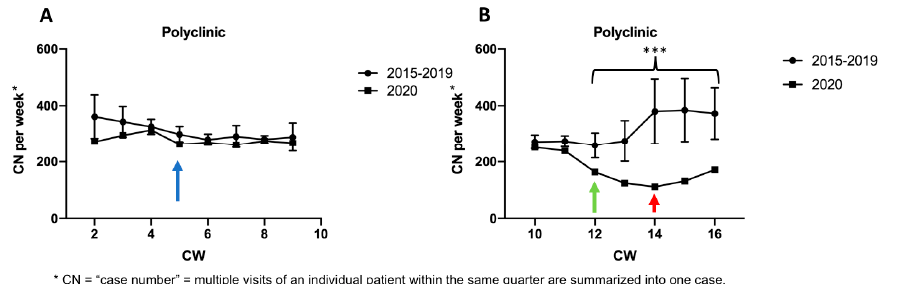
Figure 1. CN per week of the polyclinic. ( A ) Average CN per week between CW 2 and CW 9 from 2015 to 2019 compared to 2020. ( B ) Average CN per week between CW 10 and CW 16 from 2015 to 2019 compared to 2020. First case of COVID-19 reported in Bavaria in CW 5 (blue arrow), declaration of state of emergency in Bavaria in CW 12 (green arrow), beginning of the second accounting quarter in CW 14 (red arrow). Significance level was defined as p < 0.001 (***). CN, case number; CW, calendar week.